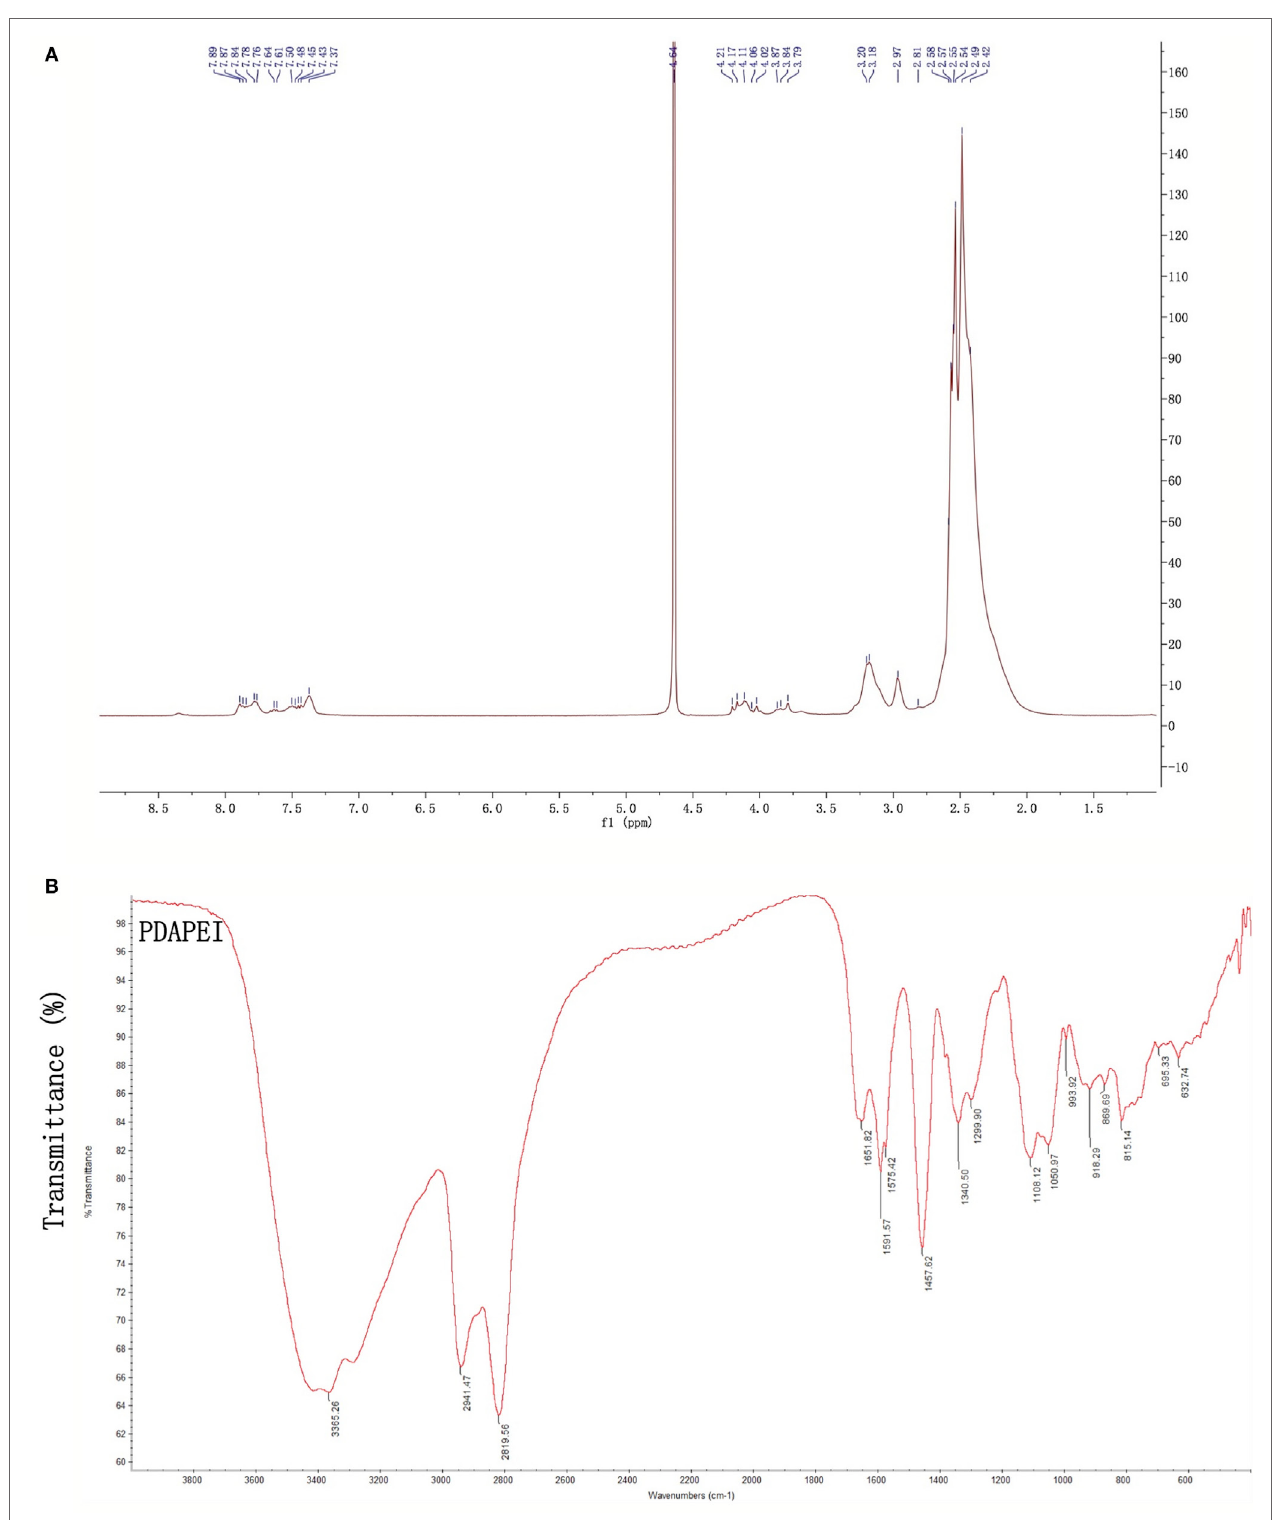
FigUre 1 | The PDaPei structure was confirmed using 1 h nMr and FT-ir . (a) NMR of PDAPEI. Chemical shifts at δ 7.7 ppm of the 1 H NMR spectrum are attributed to the protons of 2,6-pyridinedicarboxaldehyde. (B) IR of PDAPEI. This attribution is in agreement with the stretching vibration of the carbonyl group at 1,651 cm − 1 in the FT-IR spectrum for 2,6-Pyridinedicarboxaldehyde carbonyls.